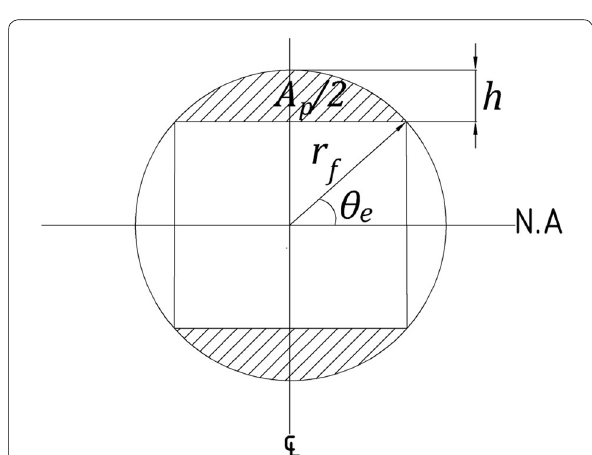
Fig. 12 The elastic and plastic zone areas of the steel fibre circular